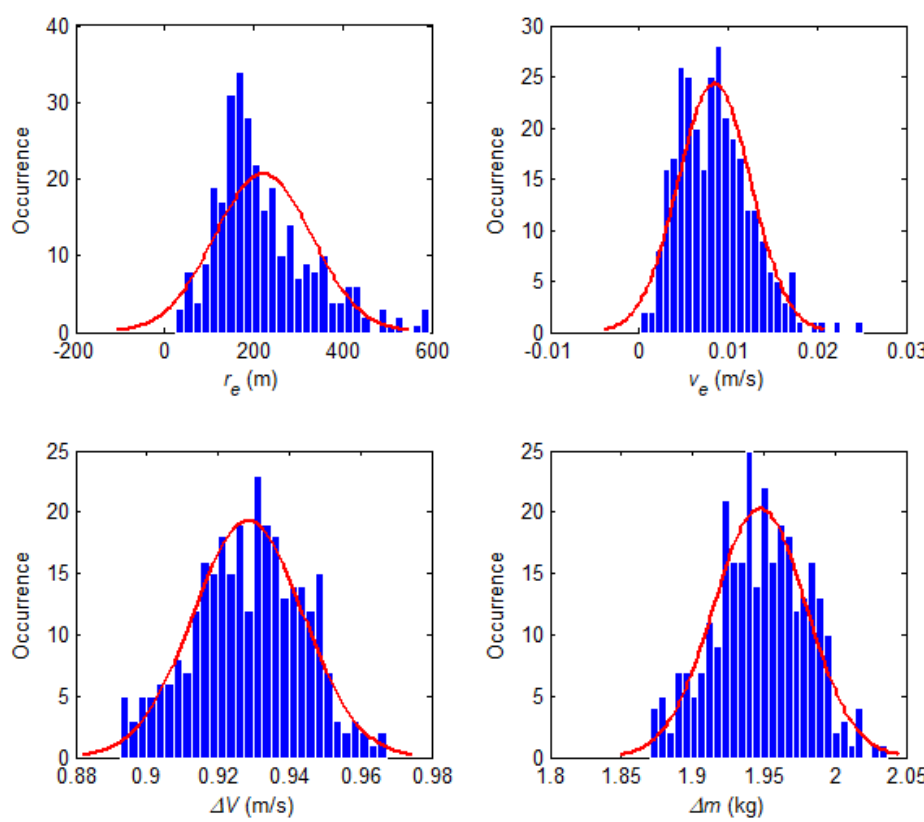
Figure 12. Occurrence of the Monte Carlo simulation (Error setting IV, ε = 2 = TOF 40 h ).